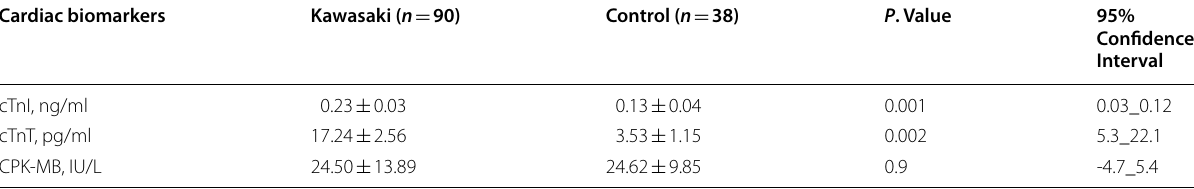
Table 2 Comparison of cTnI, cTnT and CPK‑MB as cardiac biomarkers of subclinical myocarditis in Kawasaki disease vs. control groups